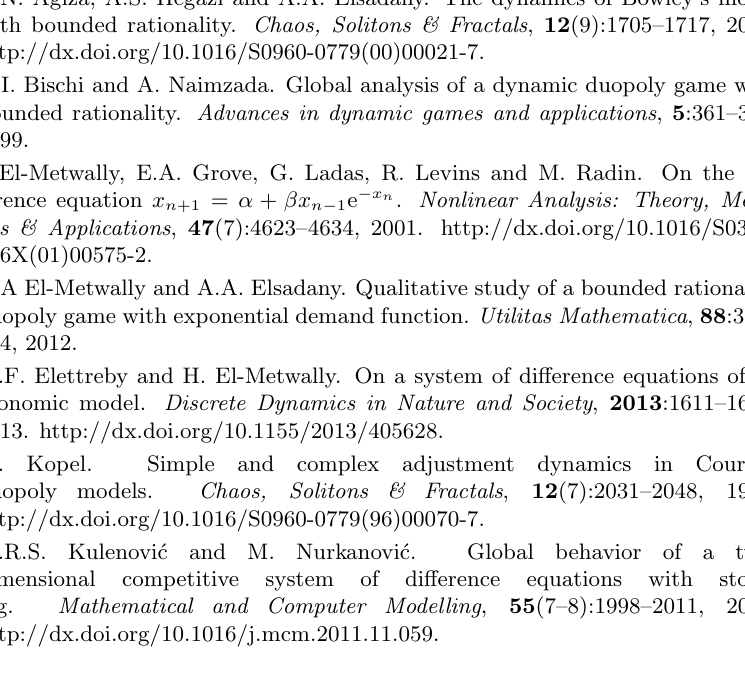
Example 2. Set α 1 = 1 . 5 , α 2 = 0 . 8 , , β 1 = 2 , β 2 = 1, Figure 2 shows the stability of equilibrium of